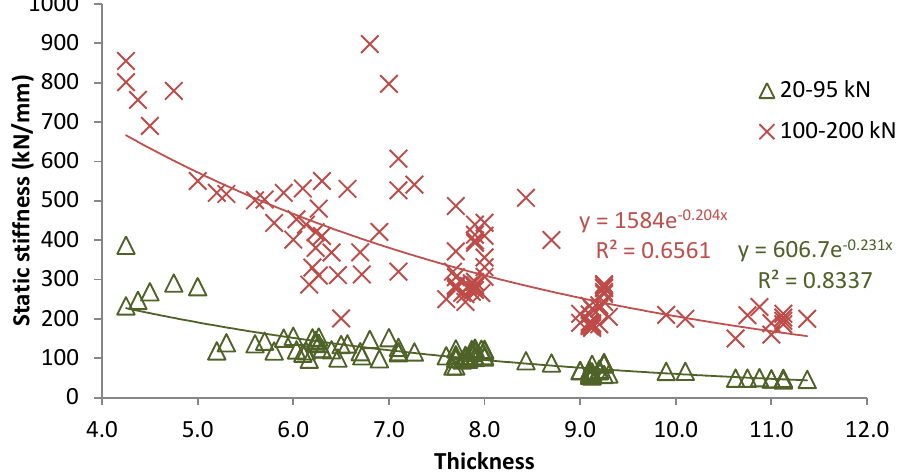
Figure 3. Effect of tire pads thickness on their static